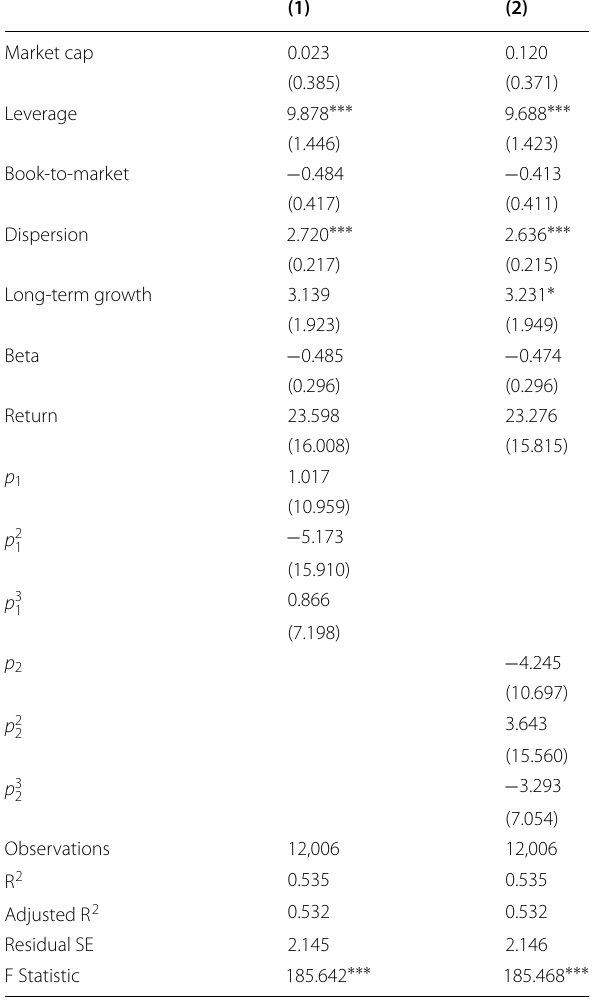
Table 10 Test of selection on unobservable